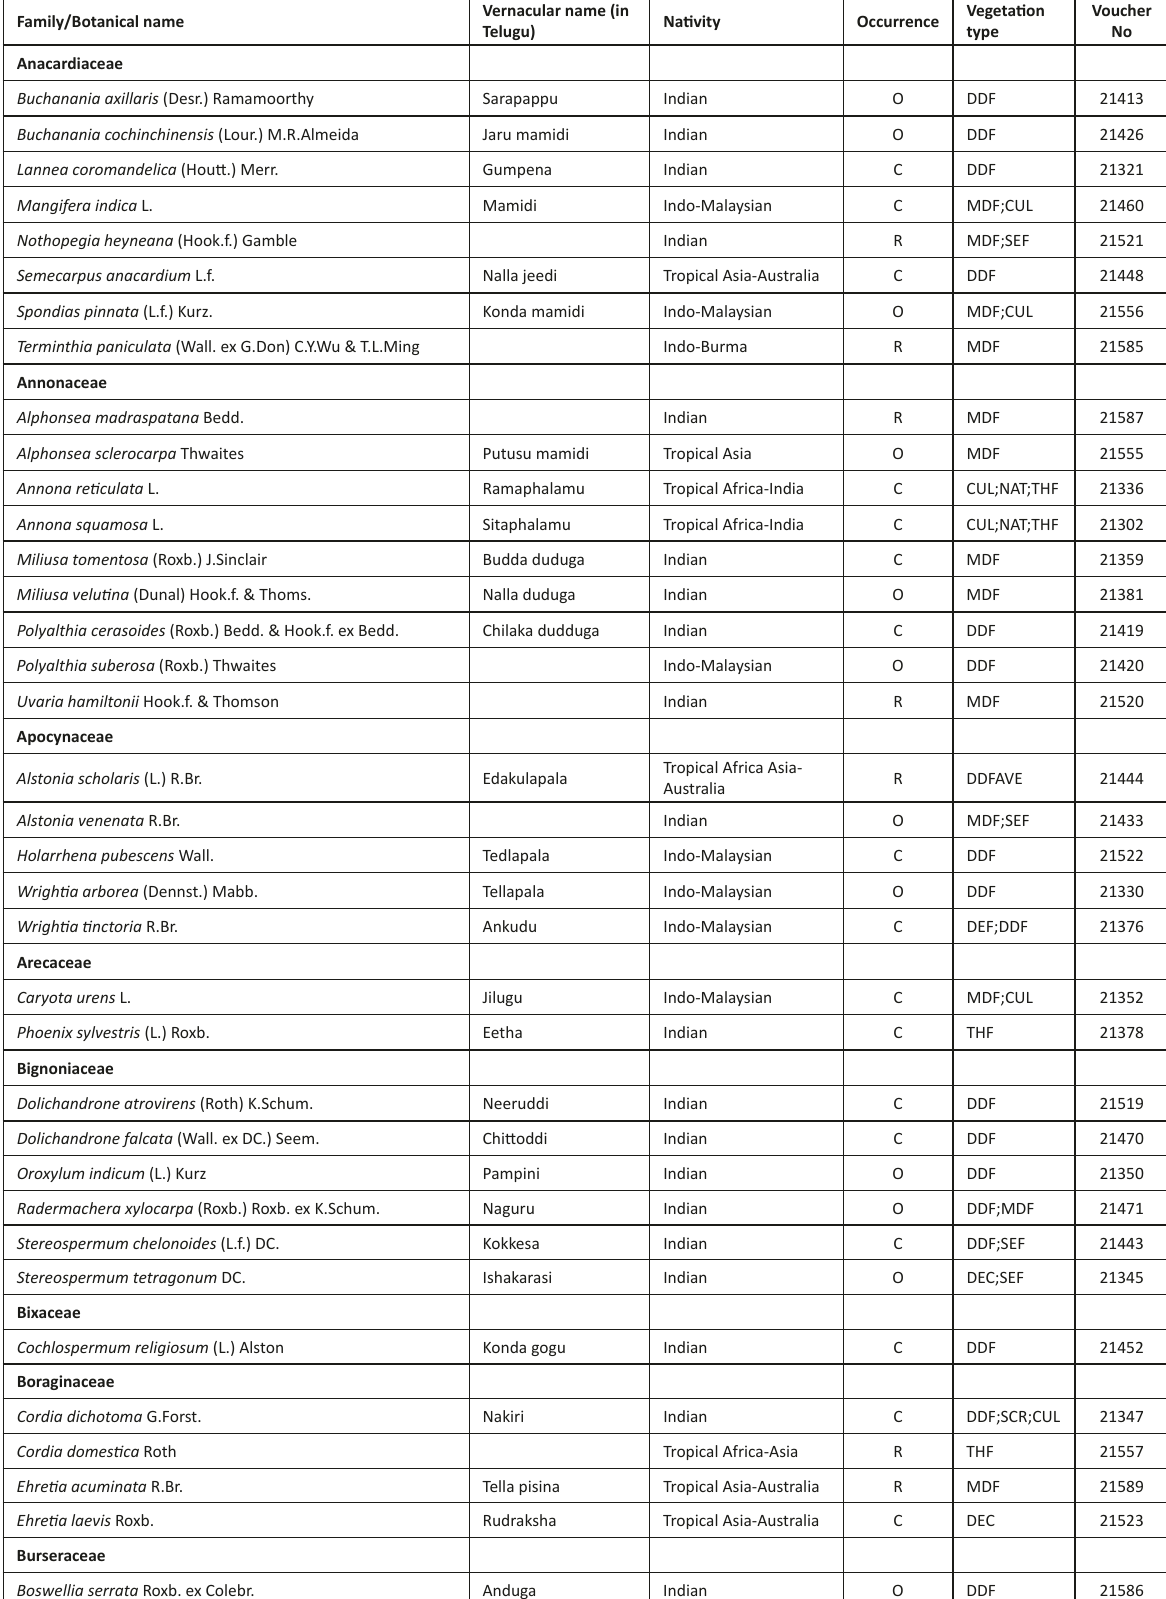
Table 1. List of tree species recorded in the Eastern Ghats of northern Andhra Pradesh Family/Botanical